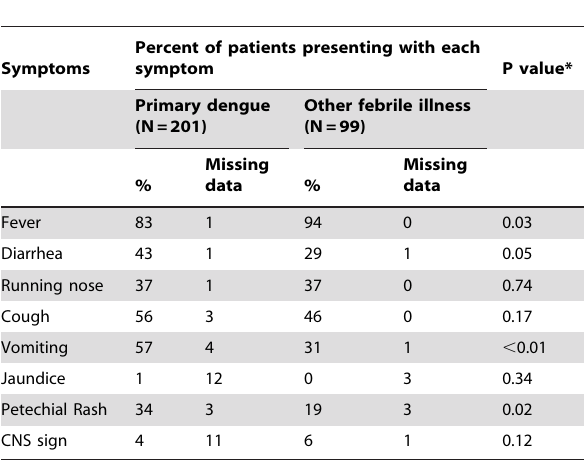
Table 2. Clinical symptoms in dengue and non-dengue patients at the time of study enrolment.